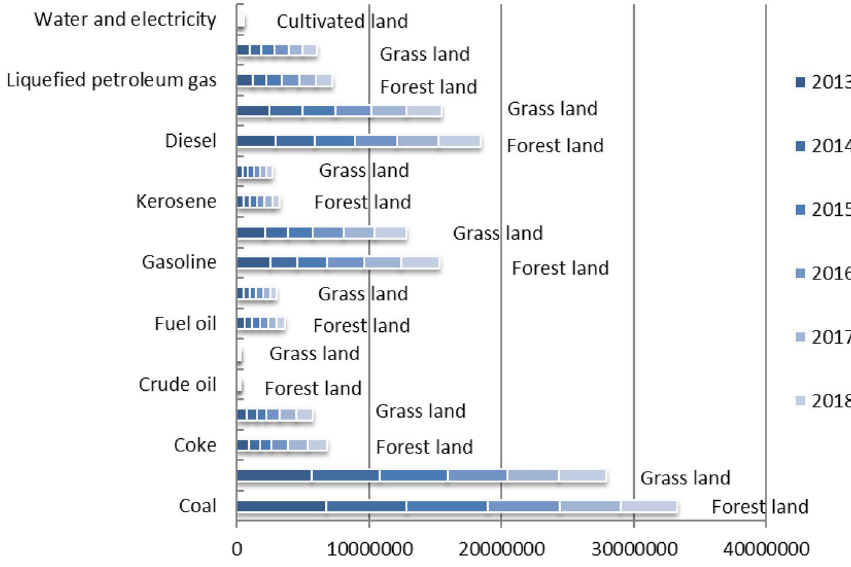
Figure 3. Ecological footprint of energy accounts in Guangdong Province from 2013 to 2018 (hm 2 ).